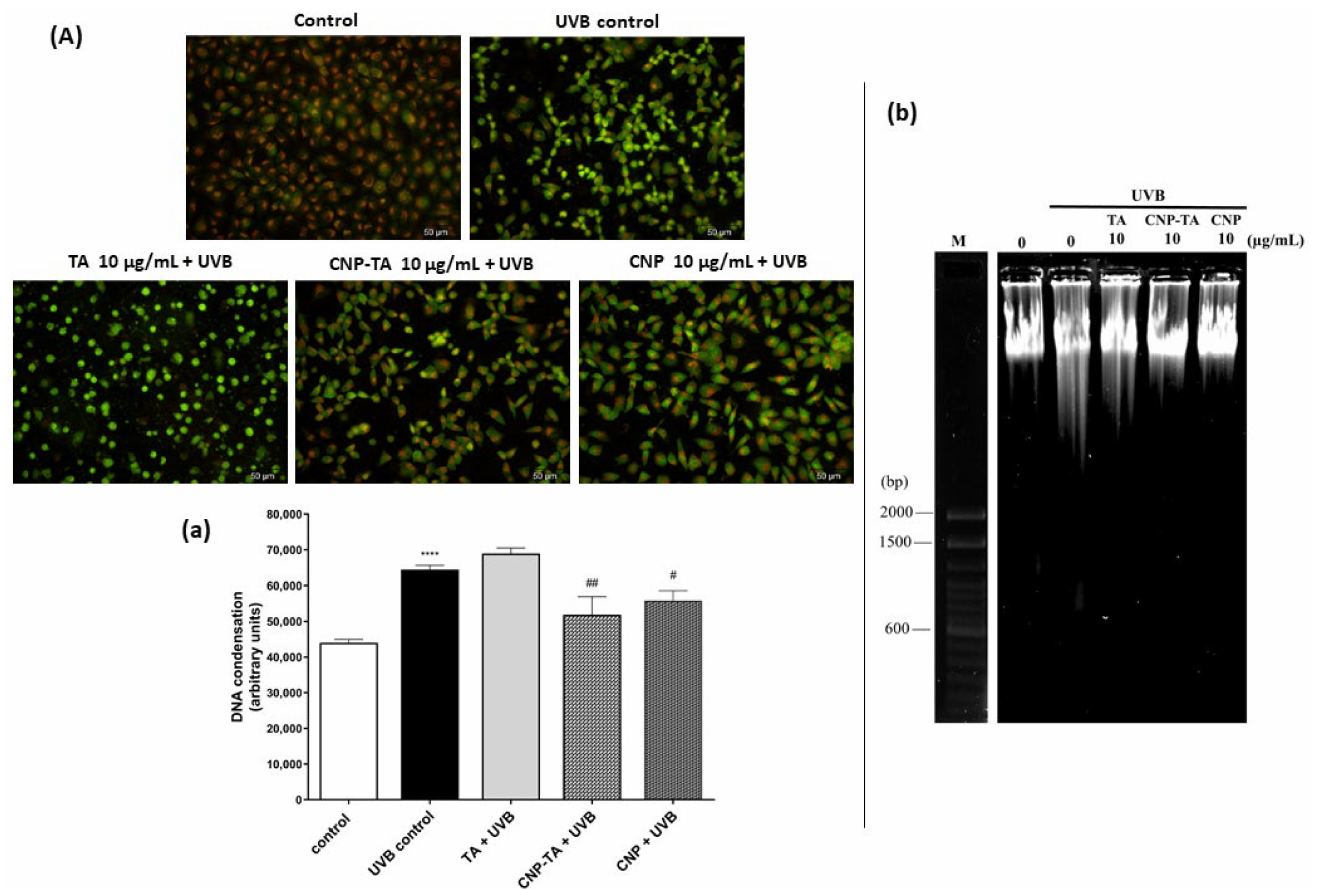
Figure 6. Effect of TA, CNP-TA and CNPs on DNA protection in L-929 fibroblasts treated (10 µ g/mL) and irradiated with UVB. ( A ) Acridine orange staining: Cells were photographed using fluores- cence microscopy (scale bar: 50 µ m). The images are representative of three independent experi- ments: ( a ) five random images from each experiment were quantified using ImageJ software version 1.51. Control: non-irradiated and untreated cells; UVB control: irradiated and untreated cells. **** p < 0.0001 compared to control, # p < 0.05 and ## p < 0.01 compared to UVB control. ( b ) Agarose gel electrophoresis. M. DNA molecular weight marker (bp, base pairs; 100 base pair DNA ladder; Invitrogen, Waltham, MA, USA). Three experiments were carried out with similar